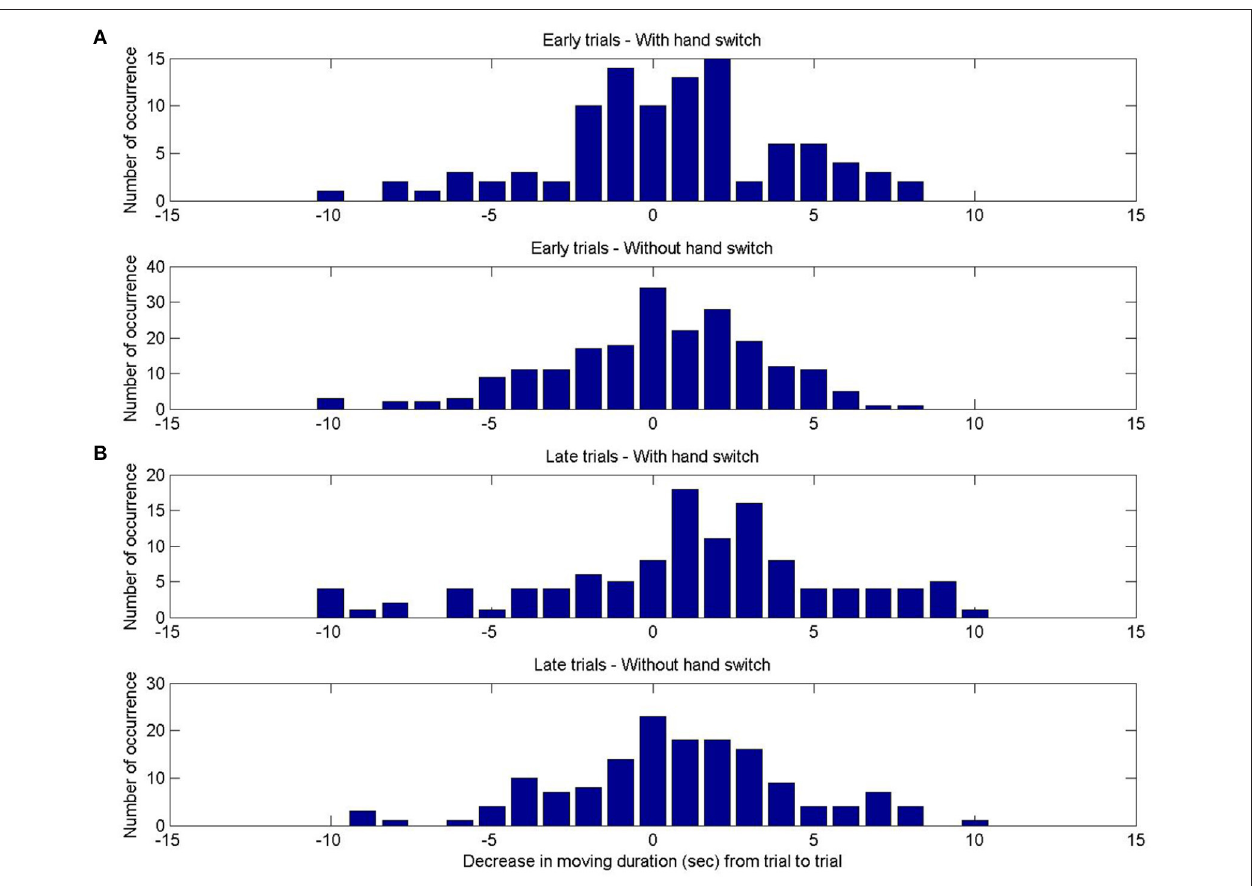
FIGURE 3 | Experimental results: Distribution of decrease in movement time between two trials. (A) In the first three habituation trials, when a hand switch occurred between trials (top) and without hand switch (bottom). (B) In the last three habituation trials, when a hand switch occurred between trials (top) and without hand switch